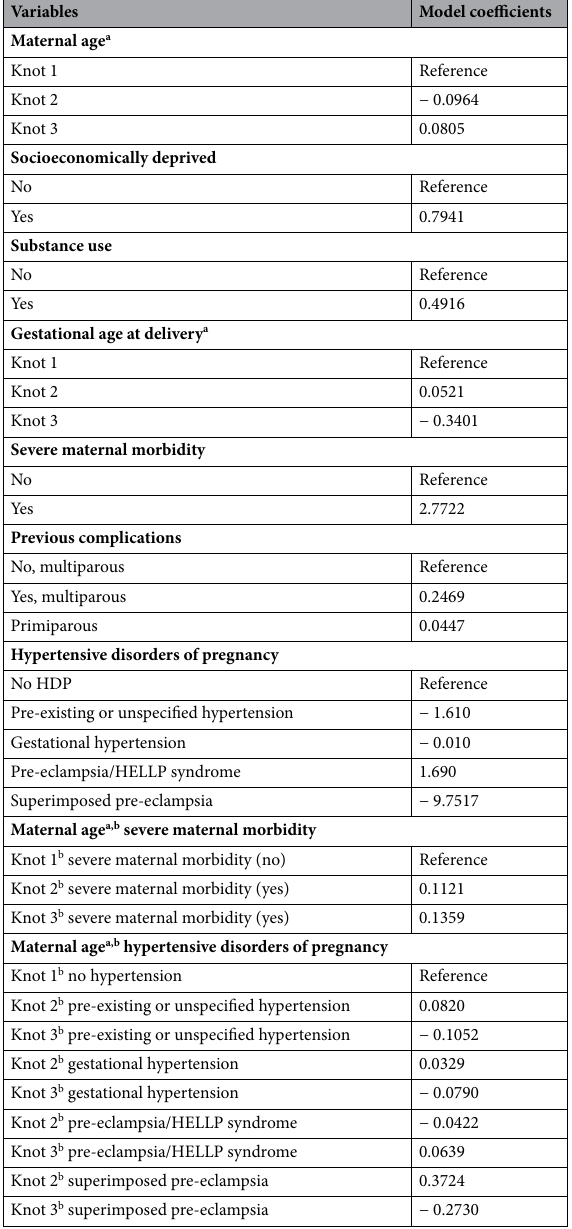
Table 3. Final prediction model with coefficients for prediction of type 2 diabetic complications among women with gestational diabetes mellitus, at 10 years of follow-up, a Splines are fit for numerical variables and so coefficients are not provided in table. b Severe maternal morbidity included conditions defined by the Canadian Perinatal Surveillance System 23